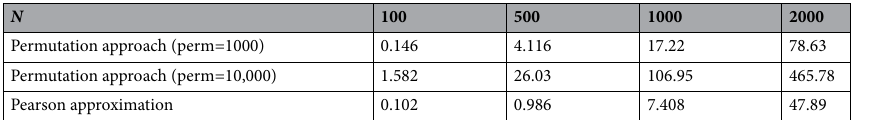
Table 2. Average runtimes in seconds from 10 simulations for each sample size N . All experiments were run by R on 2.2 GHz Intel Core